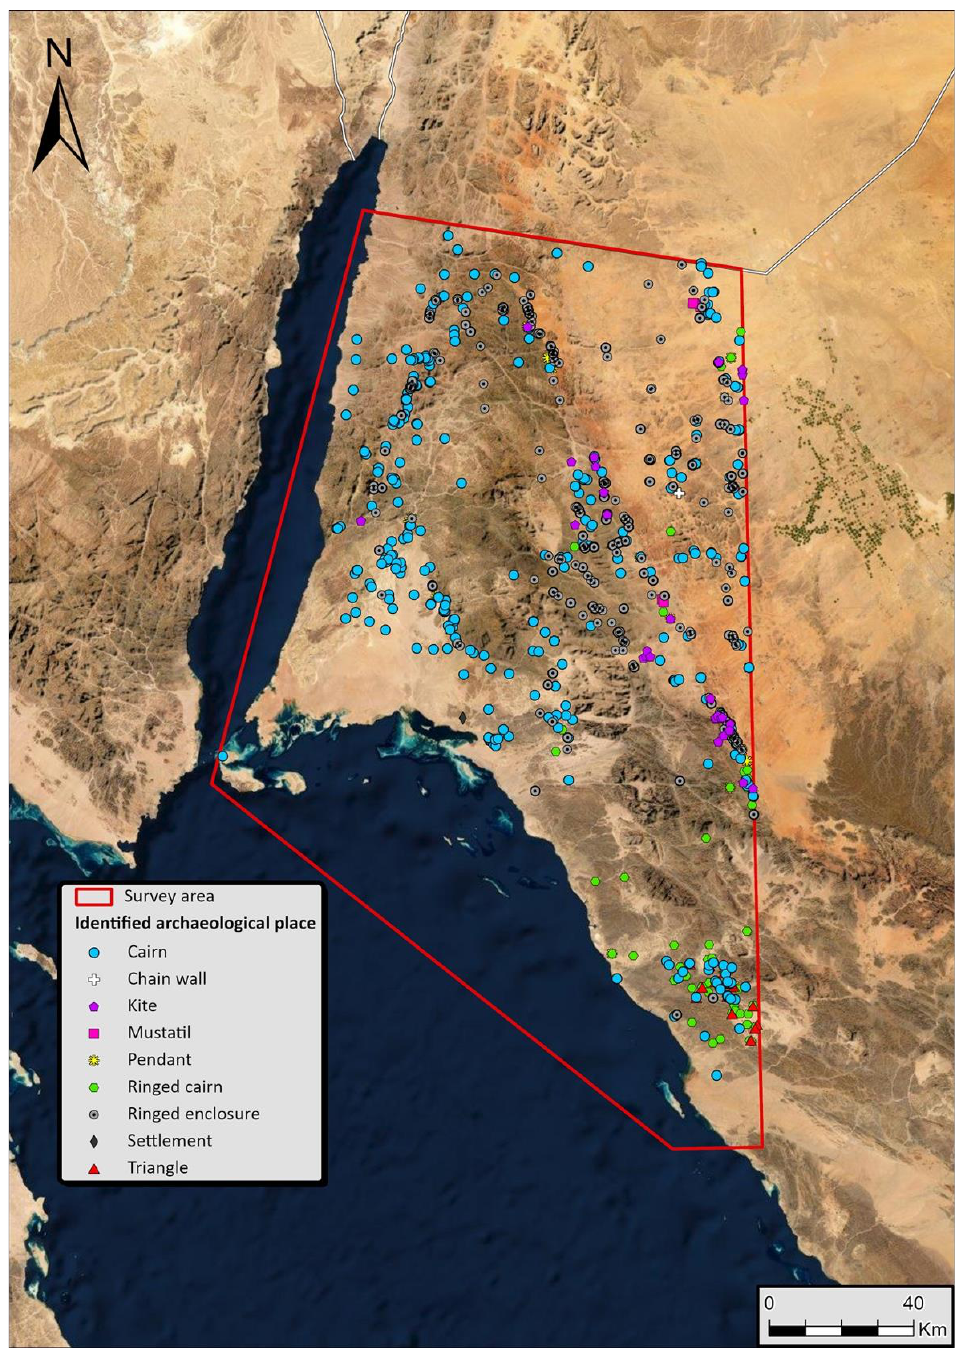
Figure 6. Main site types ’ distribution.